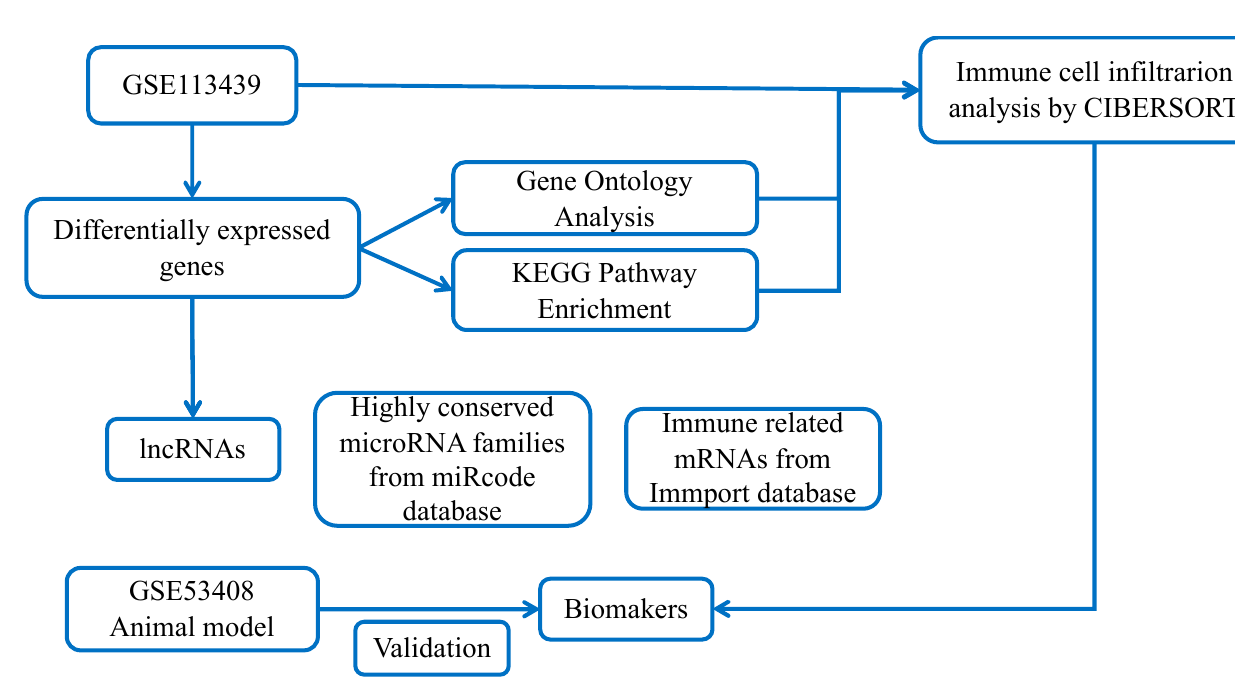
Figure 8. Study flowchart.